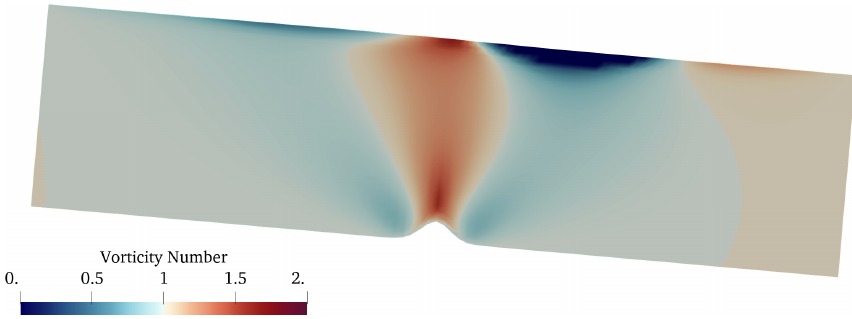
Figure 4. The vorticity number for ice flowing over a Gaussian bump, performed in Elmer/ICE (Gagliardini et al., 2013) with n = 3. The ice is flowing from left to right, down a hill with angle 3.0 ◦ . There is no slip at the base and a free surface at the top. The bump height h = H/ 10, where H is the domain height. Over the bump the flow accelerates leading to vorticity numbers greater than